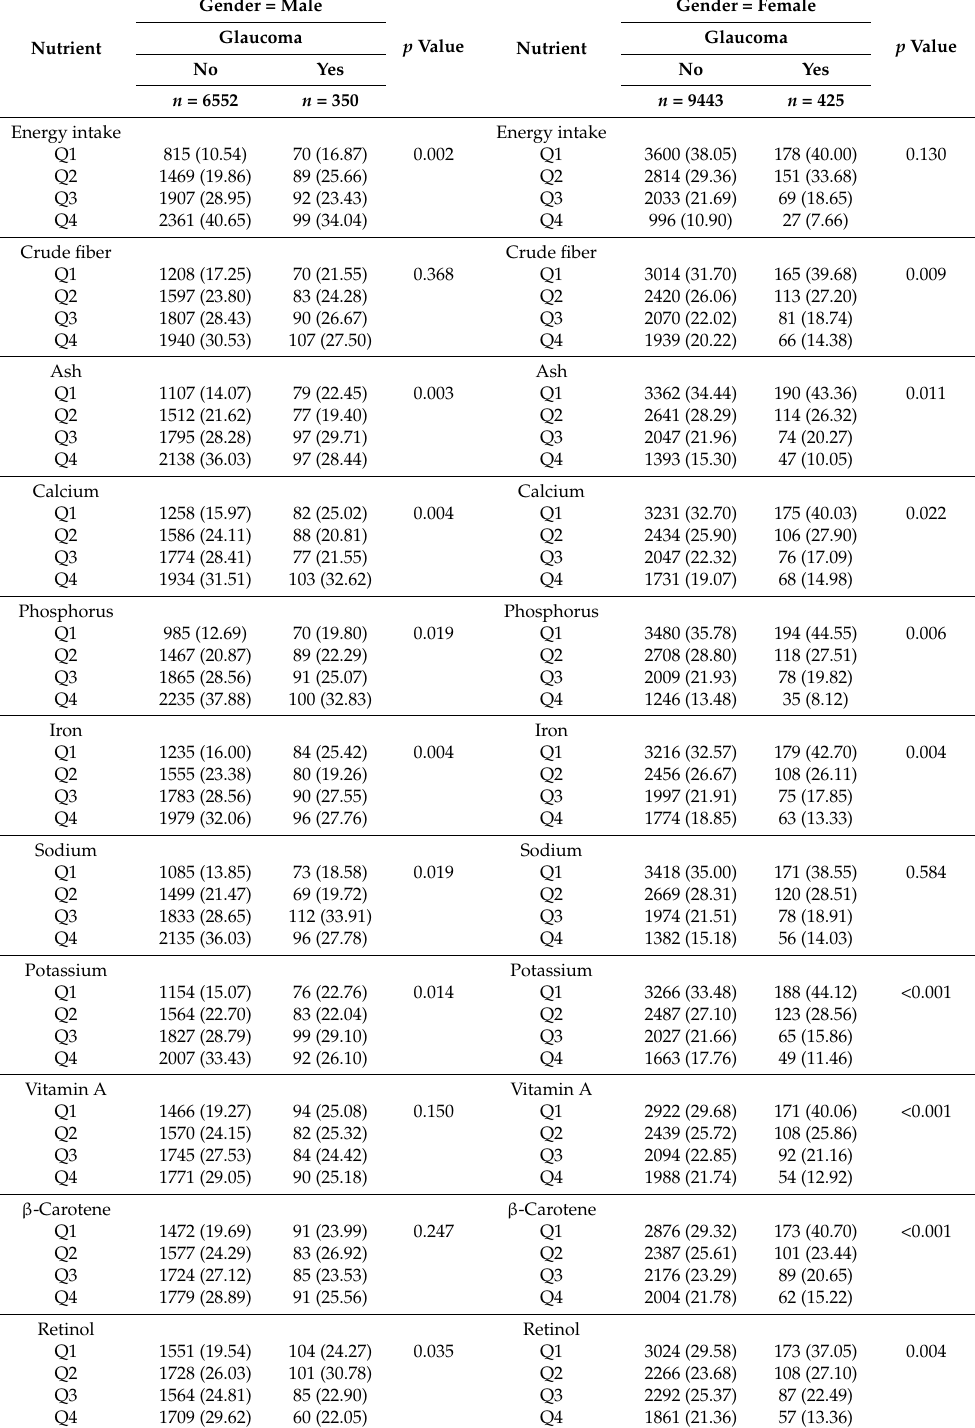
Table 3. The association between dietary nutrient intakes and